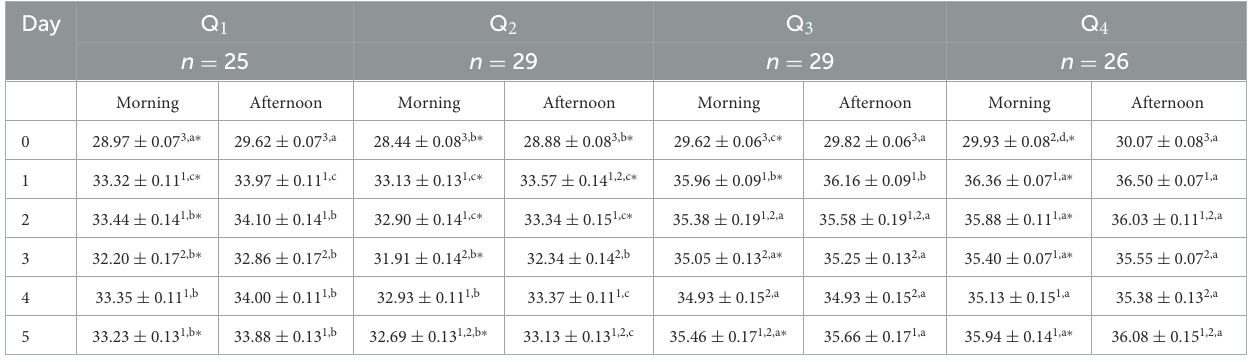
TABLE 1 Mean pelvic limb surface temperature ± standard error (SE) in newborn water buffaloes ( n = 109) at different birth weights and daytimes (morning/afternoon) during the first 6 days of life.